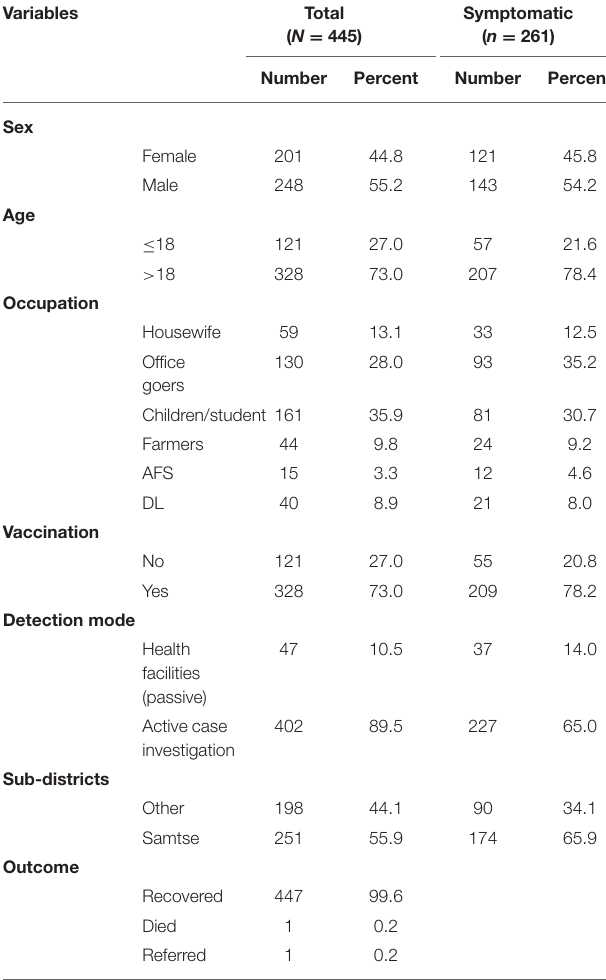
TABLE 1 | Demographic characteristics of the laboratory-confirmed COVID-19 in Samtse District, Bhutan.